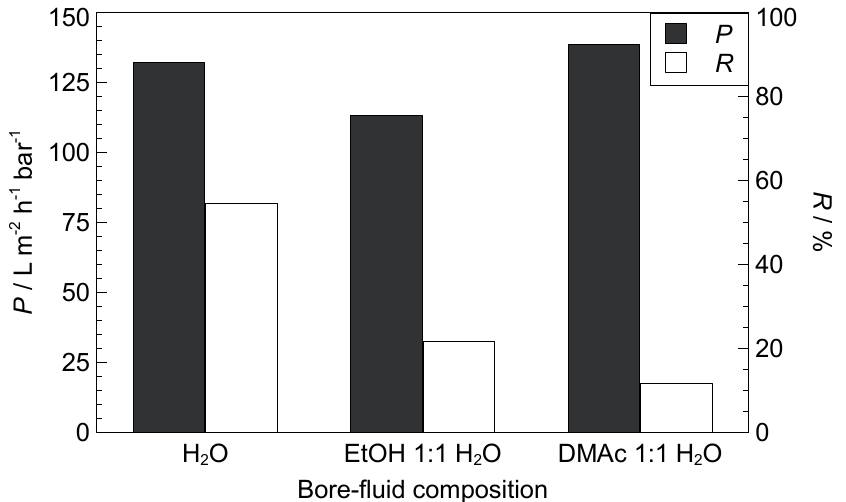
Figure 5. Permeability ( P ) and retention ( R , dextran 500 kDa) of varied bore-fluid composition. H 2 O reference membrane is ID10 (Table 1).